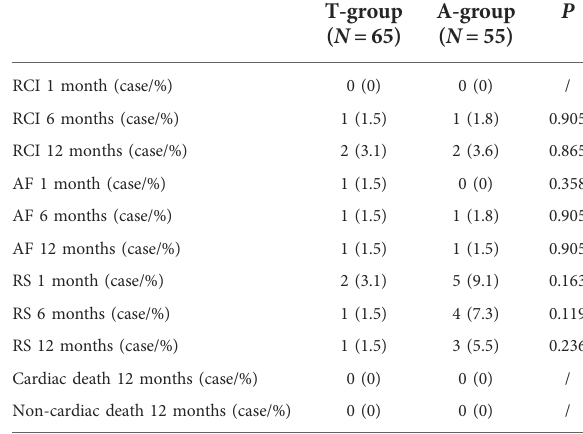
TABLE 1 Baseline clinical characteristics.